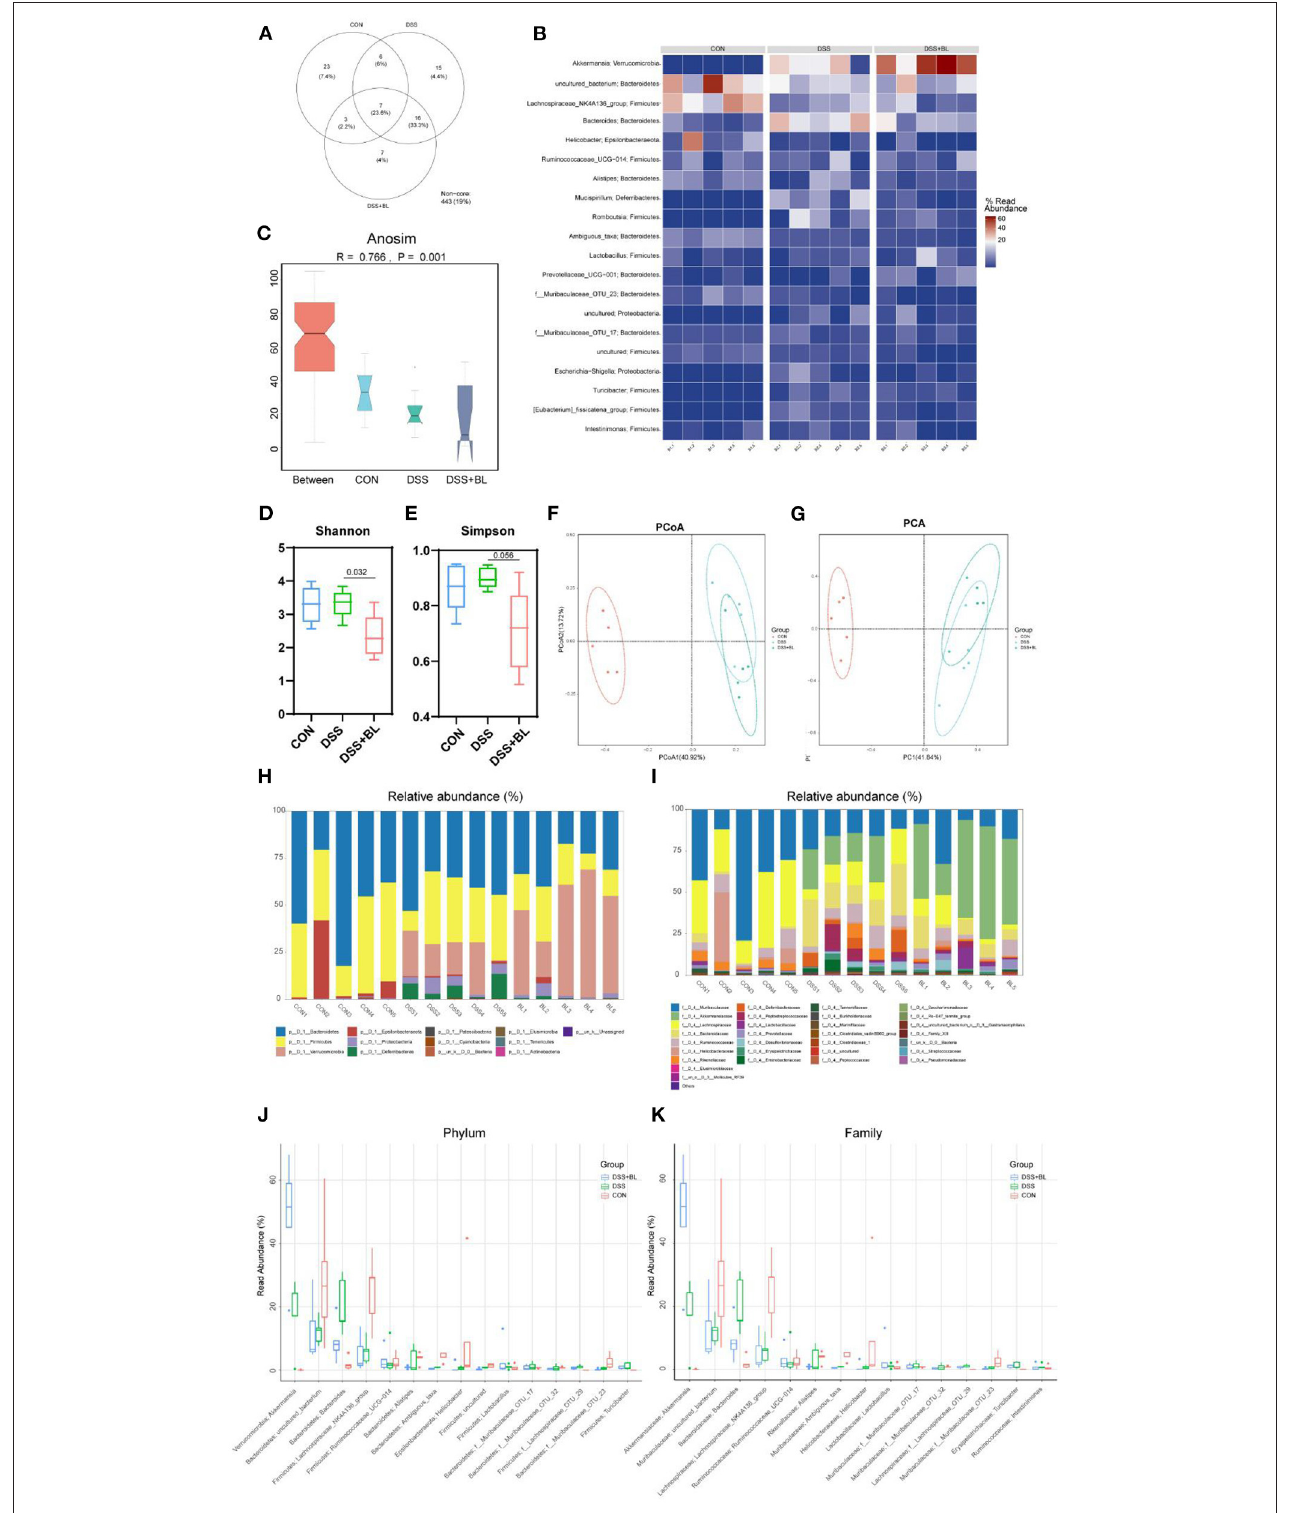
FIGURE 5 | Effects of bovine lactoferrin (BL) on gut microbial structure in dextran sulfate sodium salt (DSS) mice. (A) Venn diagram of colony structure. (B) Top 20 intestinal flora in each group. (C) Anosim analysis. (D) Shannon analysis of intestinal flora. (E) Simpson analysis of intestinal flora. (F) Principal coordinate analysis (PCoA) of intestinal flora. (G) Principal component analysis (PCA) of intestinal flora. (H,J) The expression of phylum relative abundance. (I,K) The expression of family relative abundance. One-way ANOVA was used to compare the three groups. * P < 0.05 vs. control; # P < 0.05 vs. DSS.